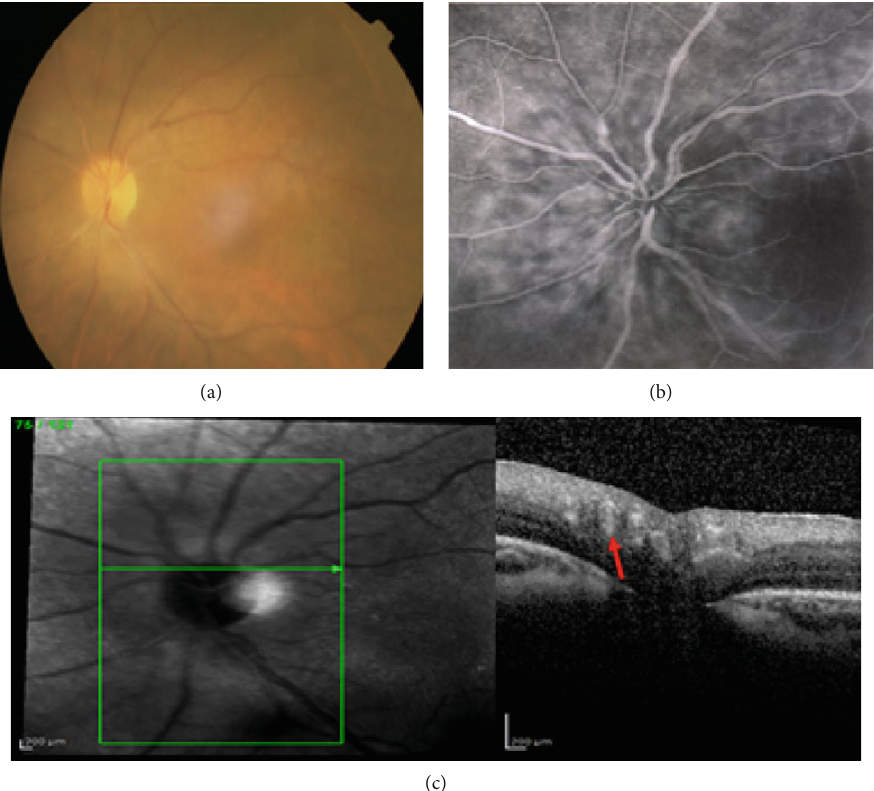
Figure 2: Case 2. (a) Fundus photography described sheathed vessels emerging from the optic disc. (b) FA showed normal vessel walls and fl ow. (c) The vessel wall re fl ectivity seemed to be normal or slightly hyperre fl ective in the SD-OCT linear scan (red